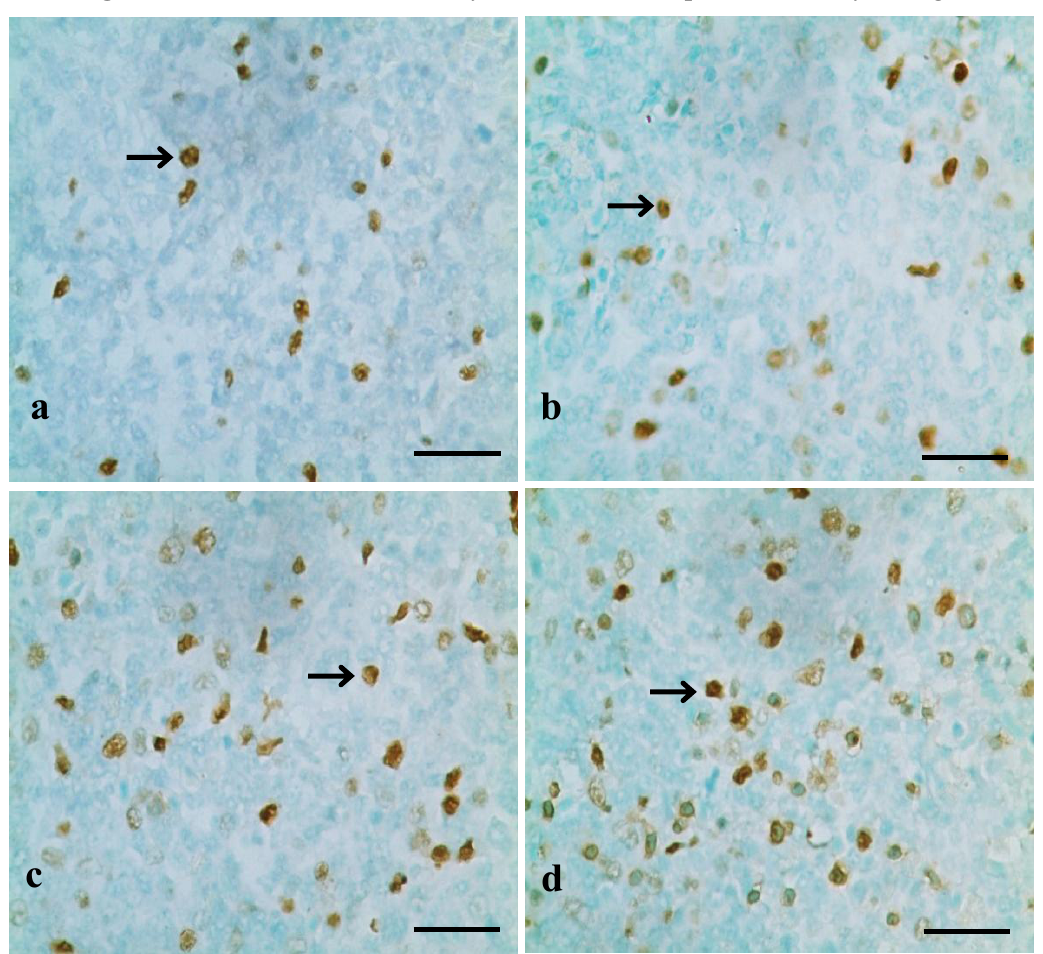
Figure 3. Positive cells stained by TUNEL in the spleen at 42 days of age.